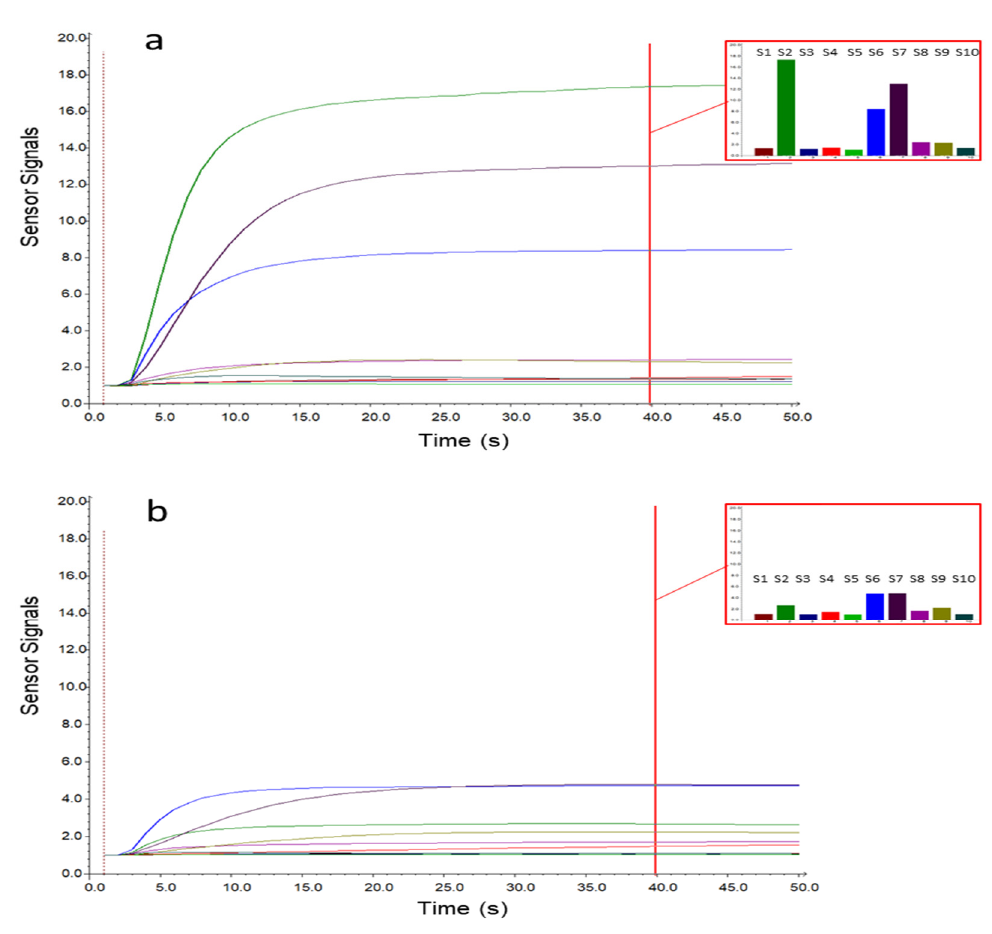
Figure 1. Metal oxide semiconductor (MOS) sensor signals for a case ( a ) and control ( b ) sample. The histograms represent the responses after 40 s of sampling for the 10 e-nose sensors (S1–10).